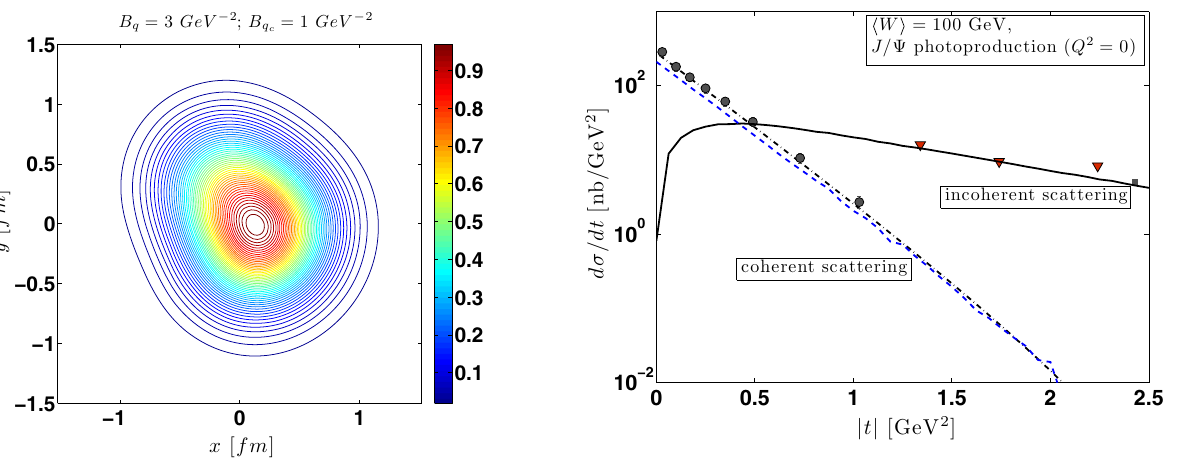
Fig. 2 Example of a smooth density profile obtained from Eq. (8) with the parameters indicated in the panel